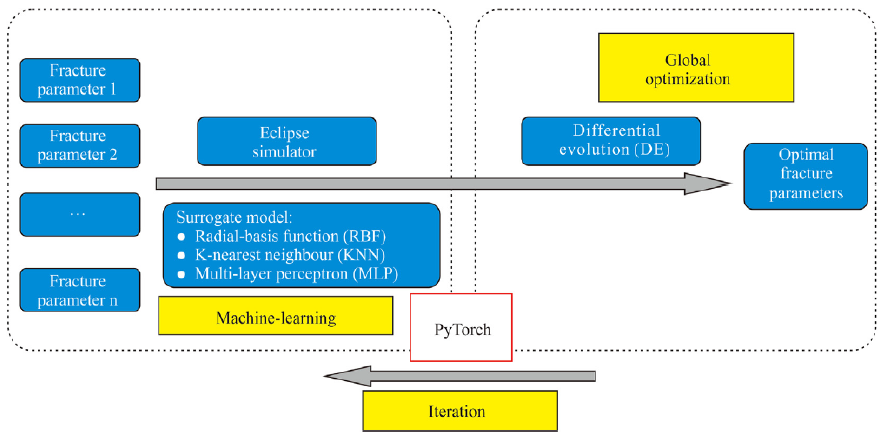
Figure 4. Integrated framework of ML and intelligent optimization algorithm. Reprinted with permission from [6], licensed under Creative Commons Attribution 4.0 International License. No changes were made to the original image.